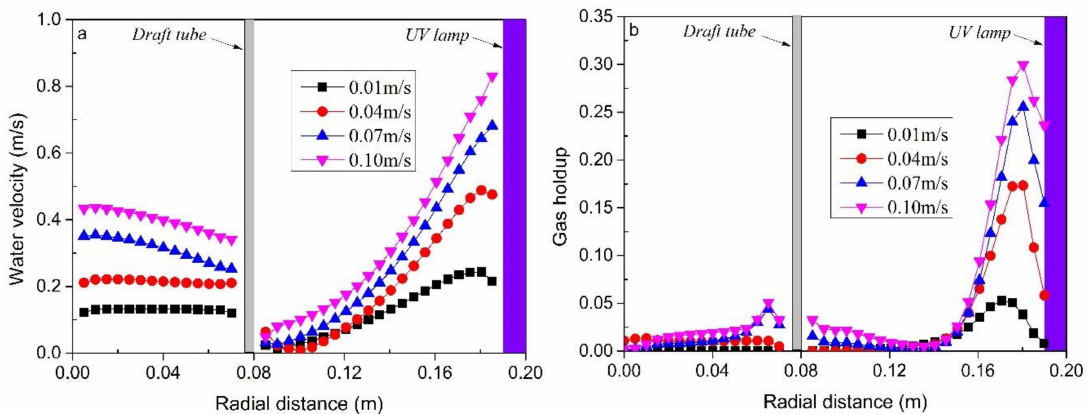
Figure 4. The radial distribution of water velocity ( a ) and gas holdup ( b ) at di ff erent gas inlet velocities in Section